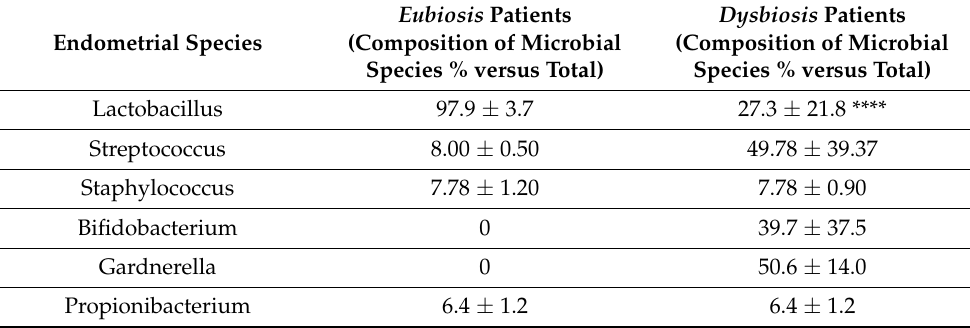
Figure 2. Subdivision of the bacterial population in the two groups. The green slice shows the percentage of the population in eubiotic conditions, while the remainder represents the population of bacteria in patients with dysbiotic conditions. Table 3. Descriptive statistics of microbial parameters for the two study groups. The data are expressed as mean ± SD. Statistical analysis was performed by unpaired t -test. **** p < 0.0001 vs. eubiosis